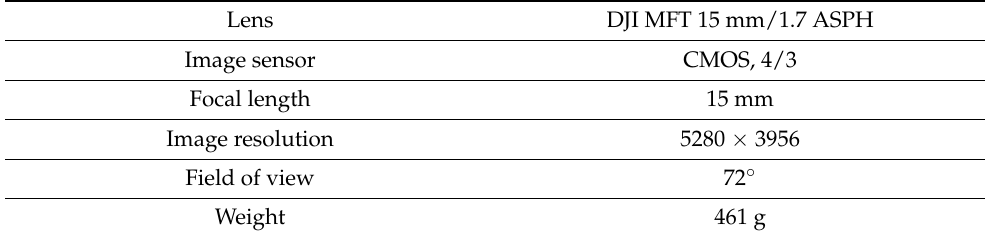
Table 2. Specification of Zenmuse X5S.